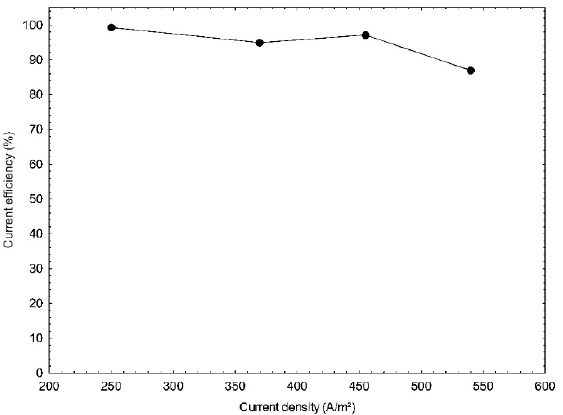
Figure 3. Determination of ideal current density. Conditions: pH = 4; room temperature; 120 min; CuSO 4 synthetic